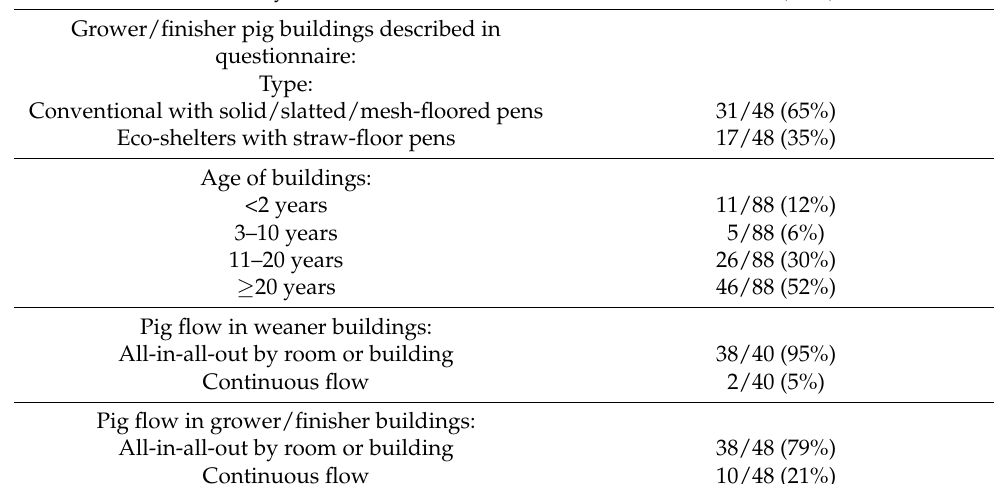
questionnaire: Type: